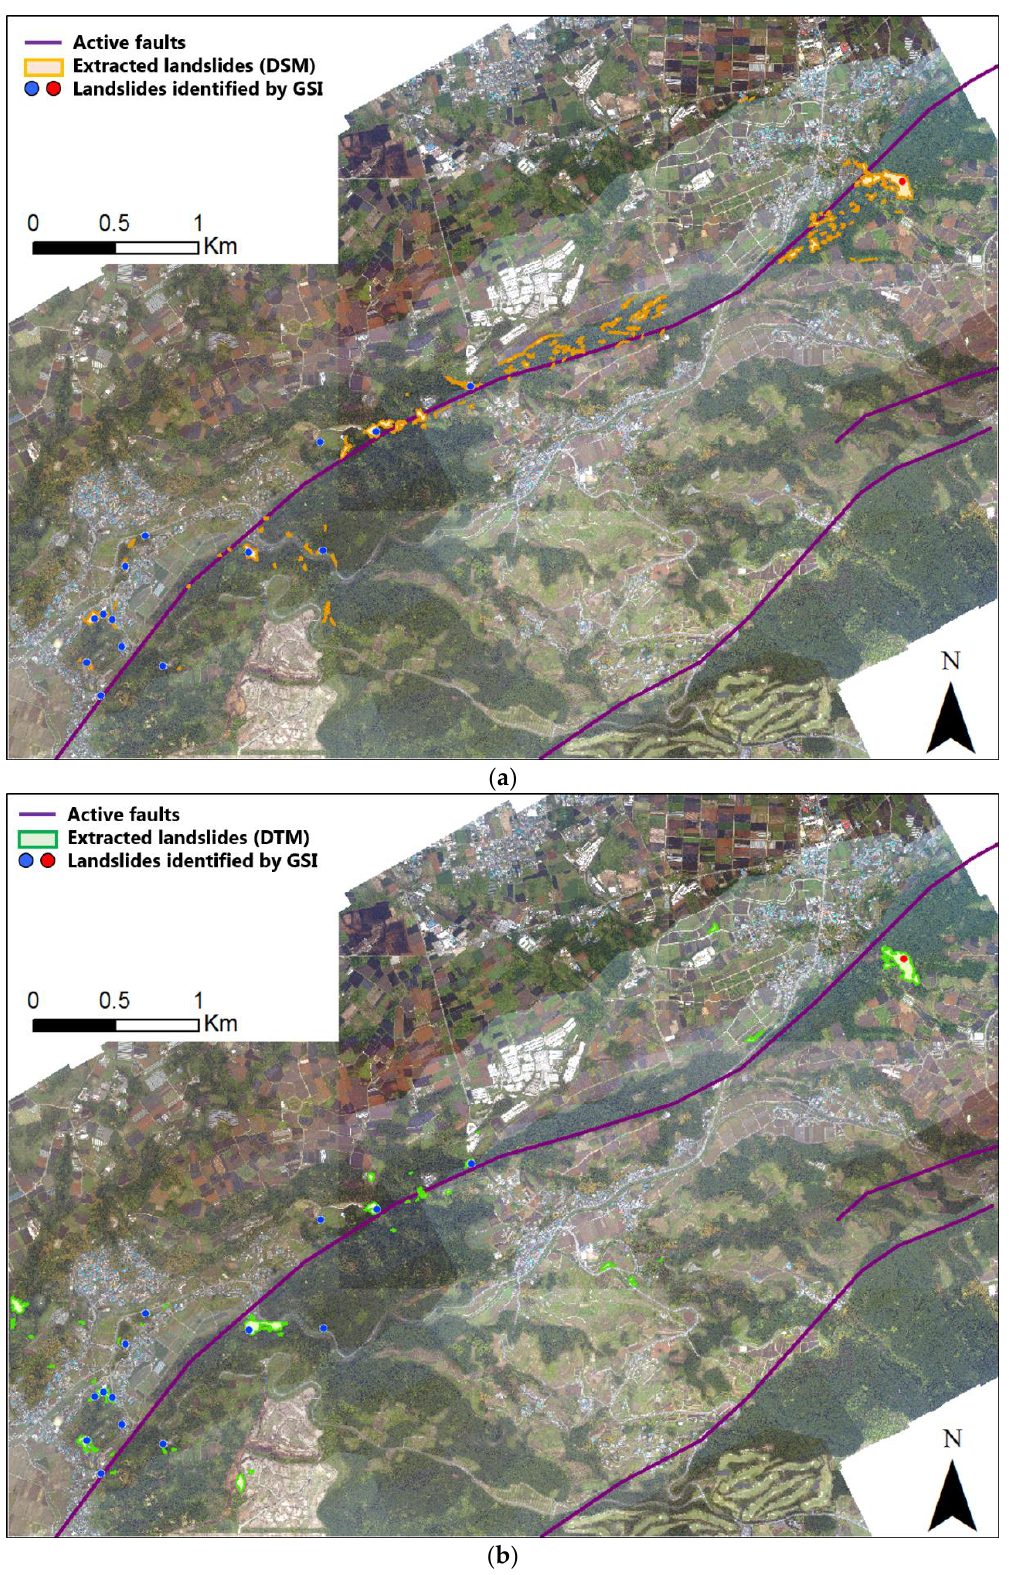
Figure 10. Comparison of the detected landslides from the DSMs ( a ) and the DTMs ( b ) with the locations of landslides published by GSI. A red point is a landslide larger than 0.01 km 2 and the blue points are landslides larger than 0.005 km 2 .